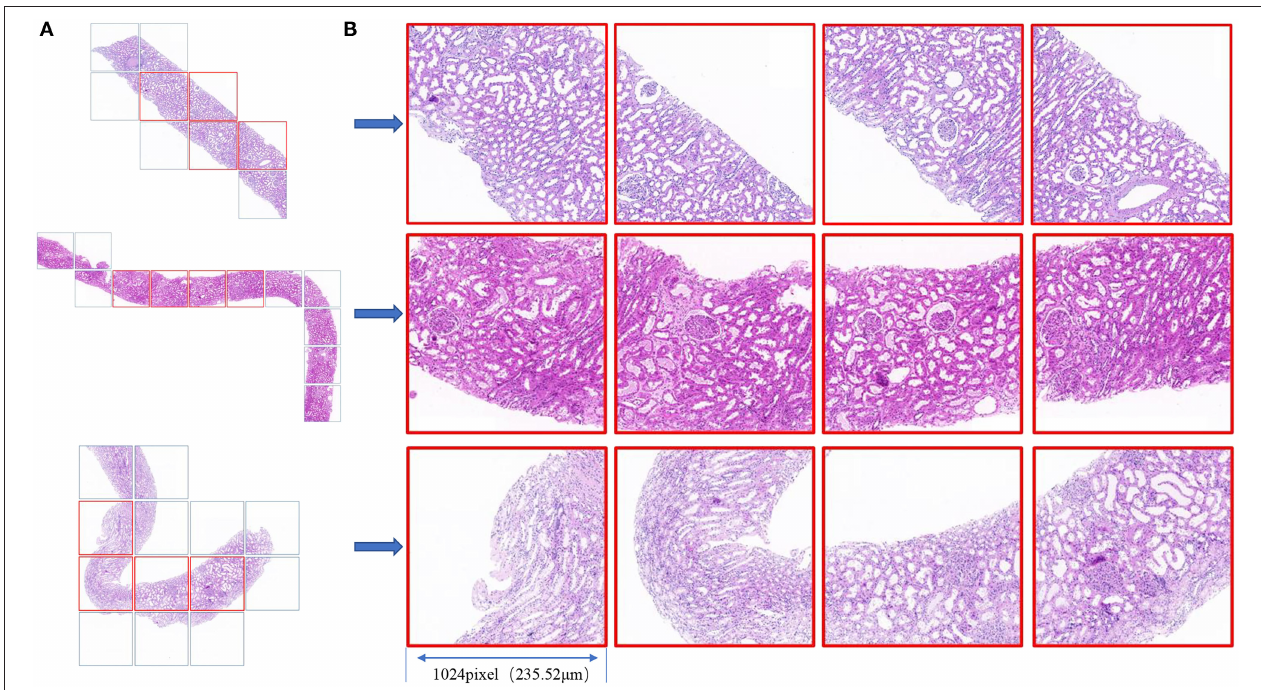
FIGURE 3 | (A) Biopsy tissue was scanned as a WSI under a × 20 objective lens, and the slide window with a 1,024 window width was used for tiling the WSI to patches (square box). (B) The four patches with the largest proportion of pathological tissue in each WSI are framed in red. The field of view of each square patch is 1,024 × 1,024 pixels, corresponding to 235.52 × 235.52 µ m 2